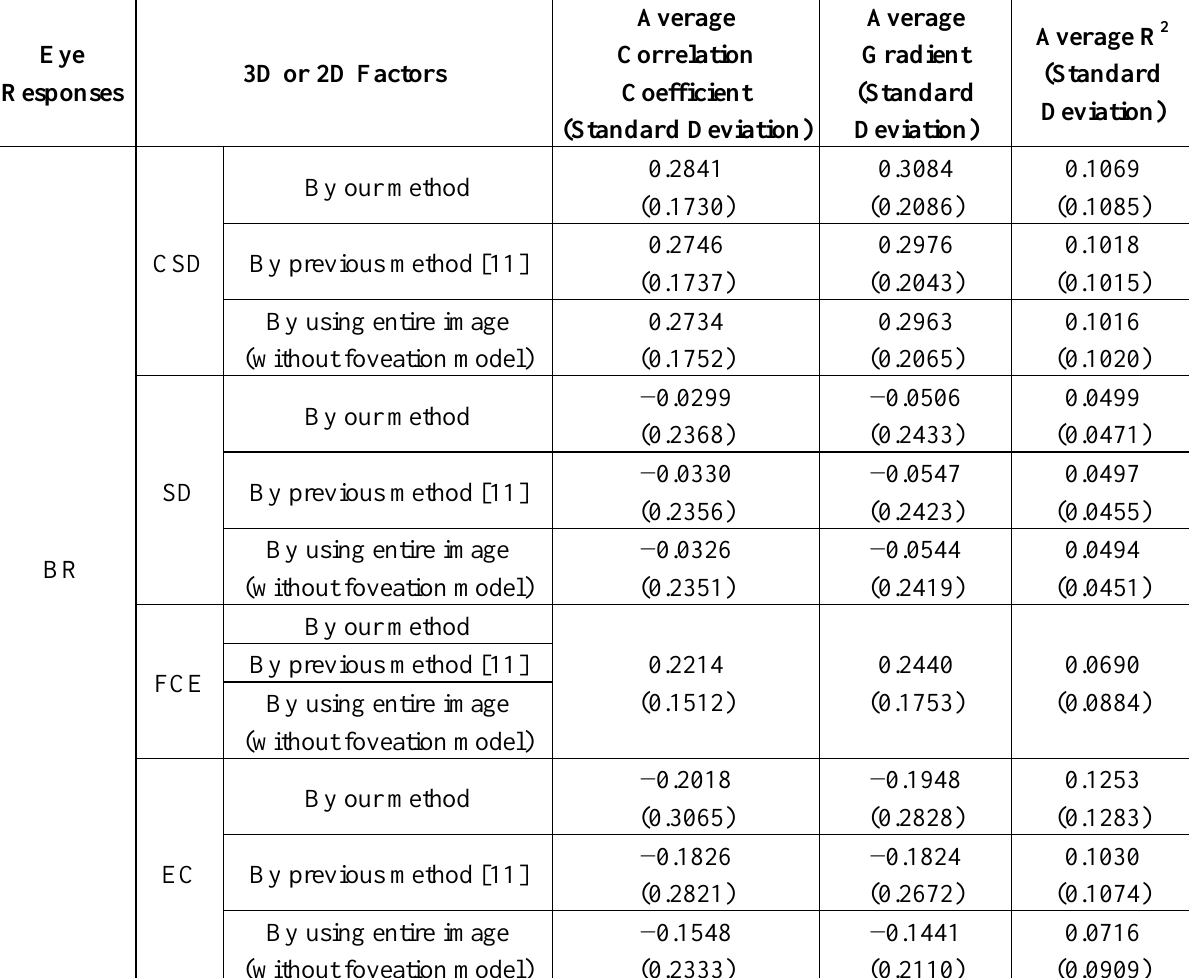
Table 1. Correlation between BR and factors for causing eyestrain on 3D